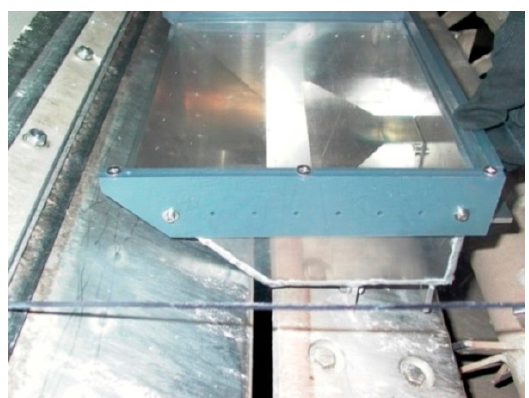
Figure 3. Resonator half assembled to the belt filter press.